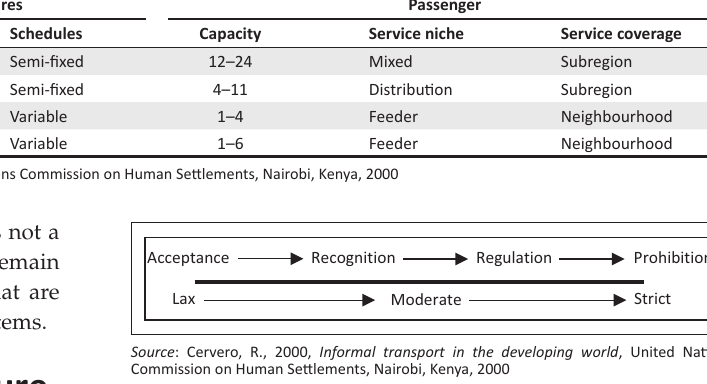
FIGURE 1: Spectrum of public policy responses to informal public